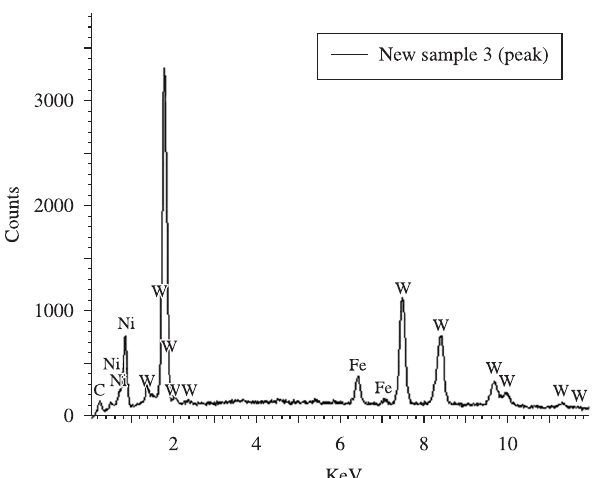
Figure 8. EDS analysis for powders milled for 32 hours.